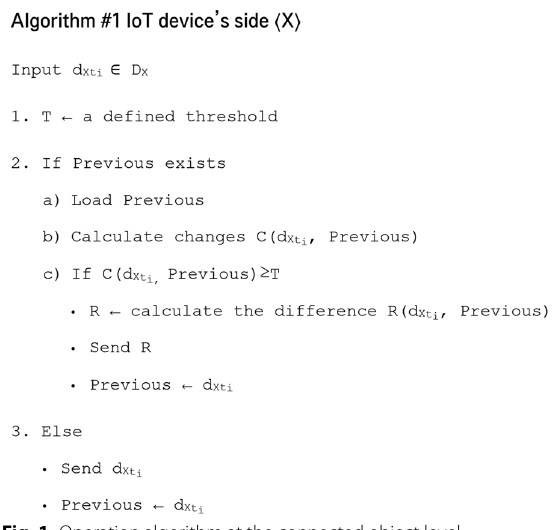
Fig. 1 Operation algorithm at the connected object level